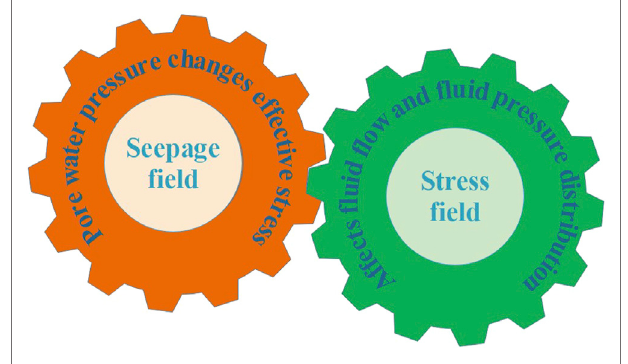
FIGURE 1 | Diagram of the fl uid – structure interaction.